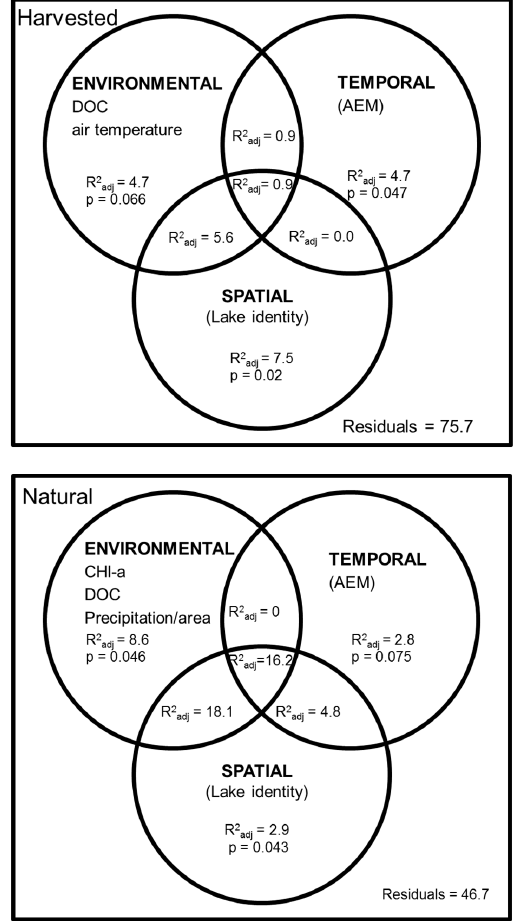
Figure 4. Percentage (R 2 adj %) of variation in zooplankton abundance explained by ENVIRONMENTAL (df = 2 and df = 3, respectively); SPATIAL (df = 2 and df = 1, respectively), and TEMPORAL (df = 1 and df = 2, respectively) variables for harvested (top panel: n =39) and undisturbed (bottom panel: n = 24) lakes. A forward selection was applied on environmental and temporal variables. Values < 0 are not shown. Based on PCA results, L80 was excluded from this analysis.